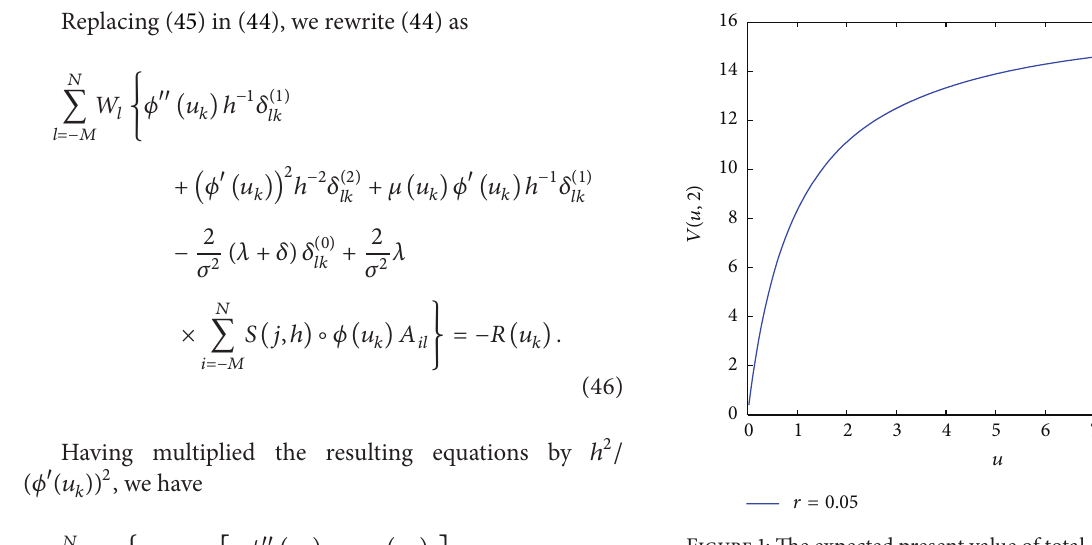
Figure 1: The expected present value of total dividends 𝑉(𝑢; 2)